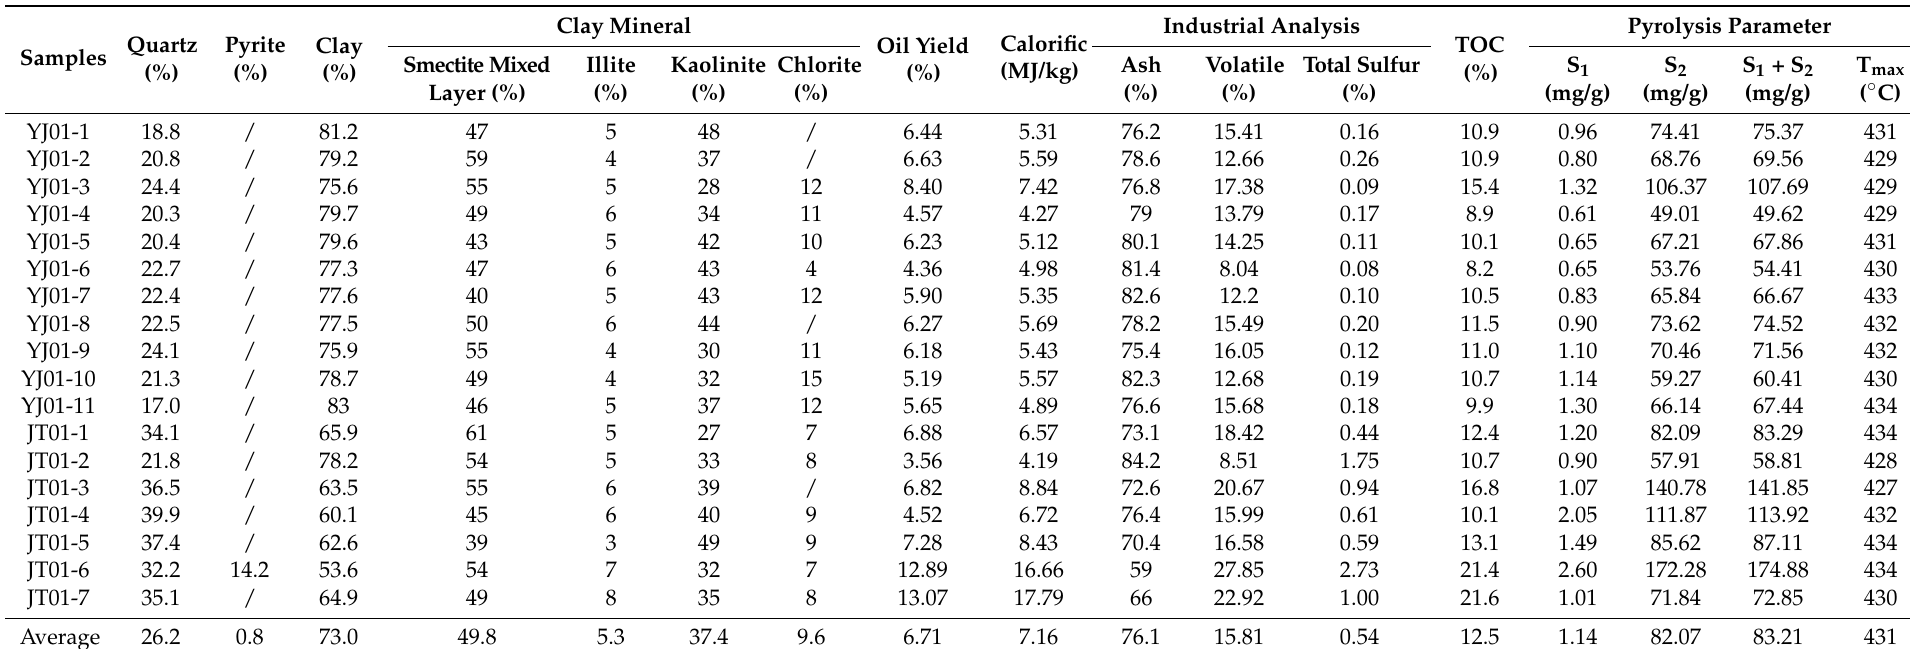
Table 1. Industrial analysis and geochemical test parameters in oil Shale of Youganwo Formation in Maoming